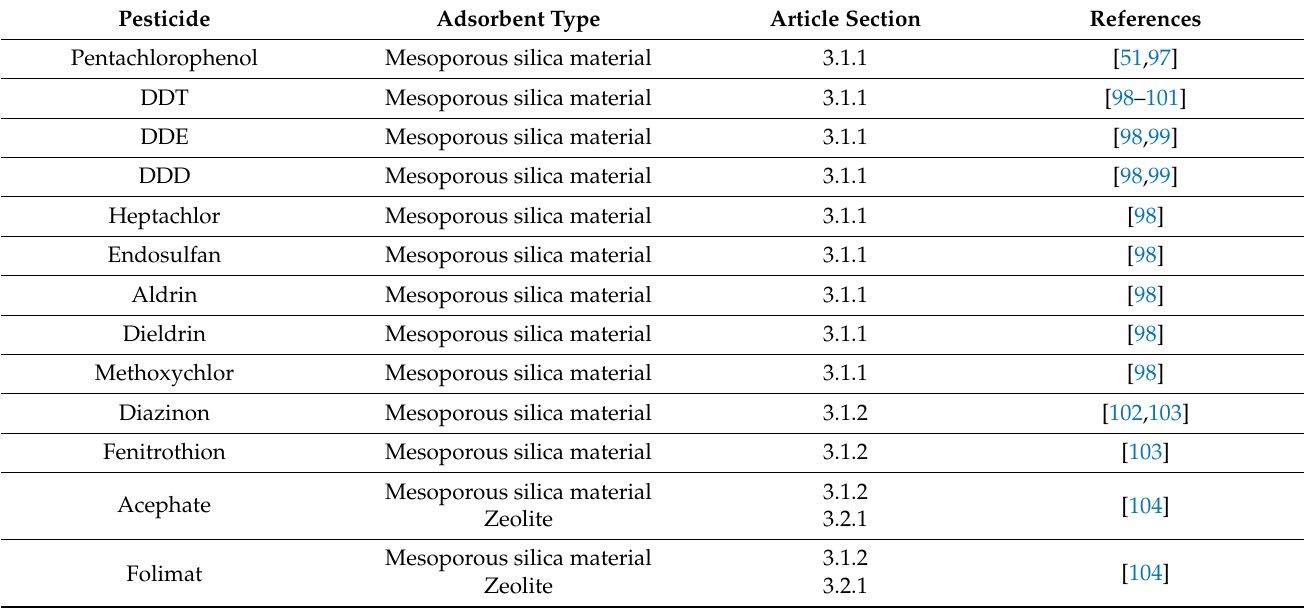
Table 2. Recapitulative table summarizing the data presented in the